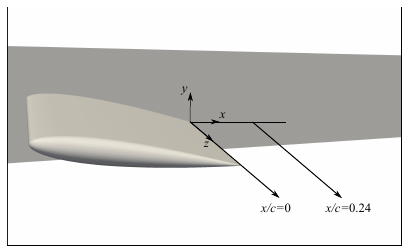
Figure 22. Evaluation